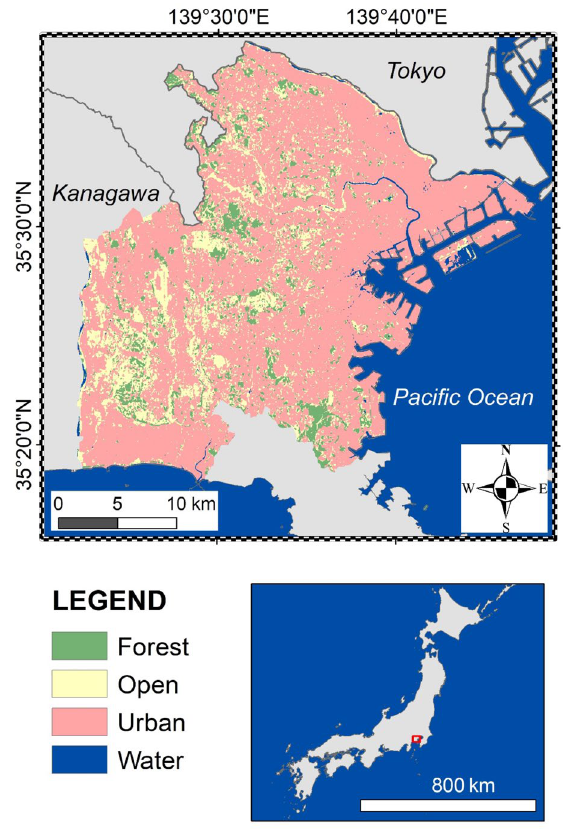
Figure 4. Study area for goshawk surveys in eastern Kanagawa, Japan (793 km 2 ). This map was generated with ArcGIS 10.8, using the land cover map issued by the Japan Aerospace Exploration Agency (https:// www. eorc. jaxa. jp/ ALOS/ lulc/ jlulc_ jpn.